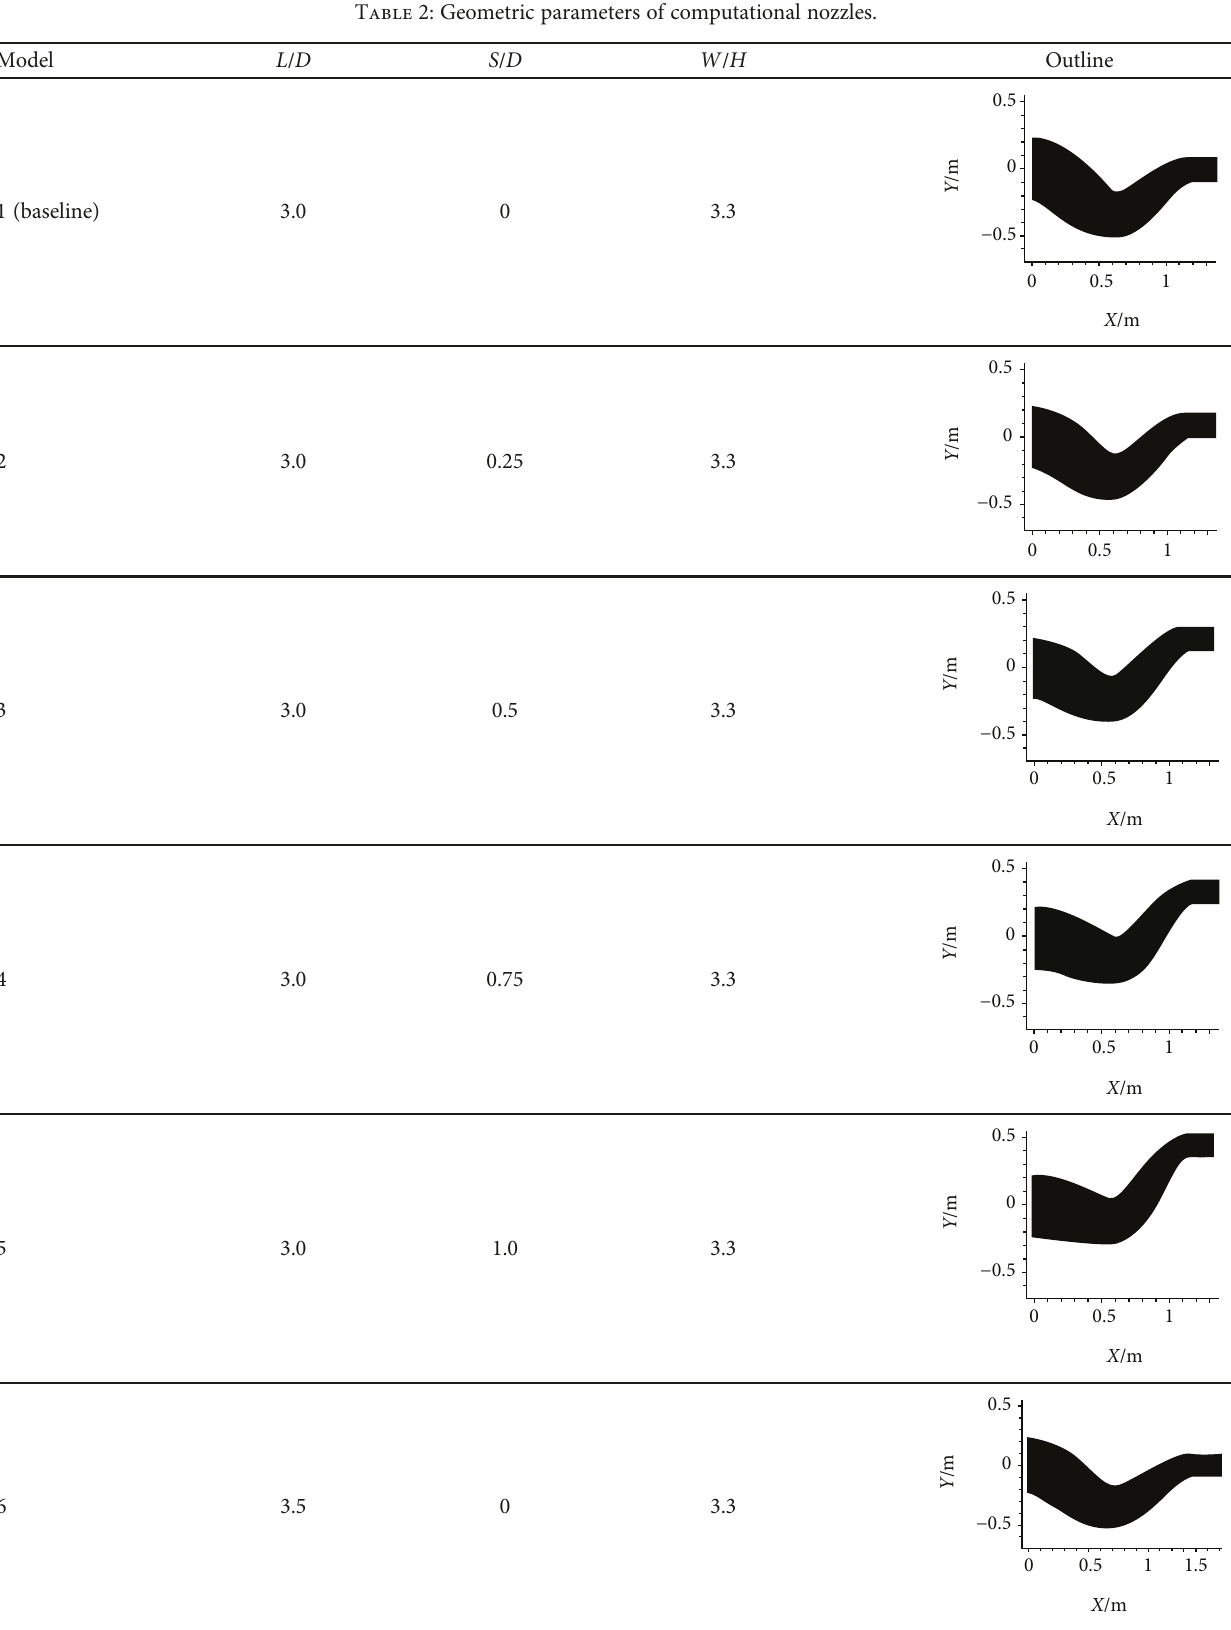
Table 2: Geometric parameters of computational